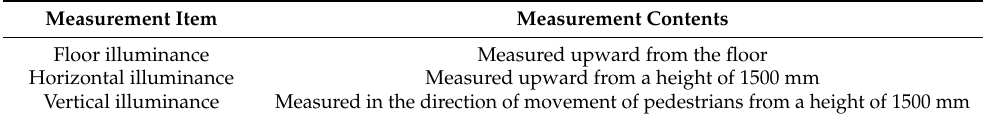
Table 3. Physical quantity measurement items.